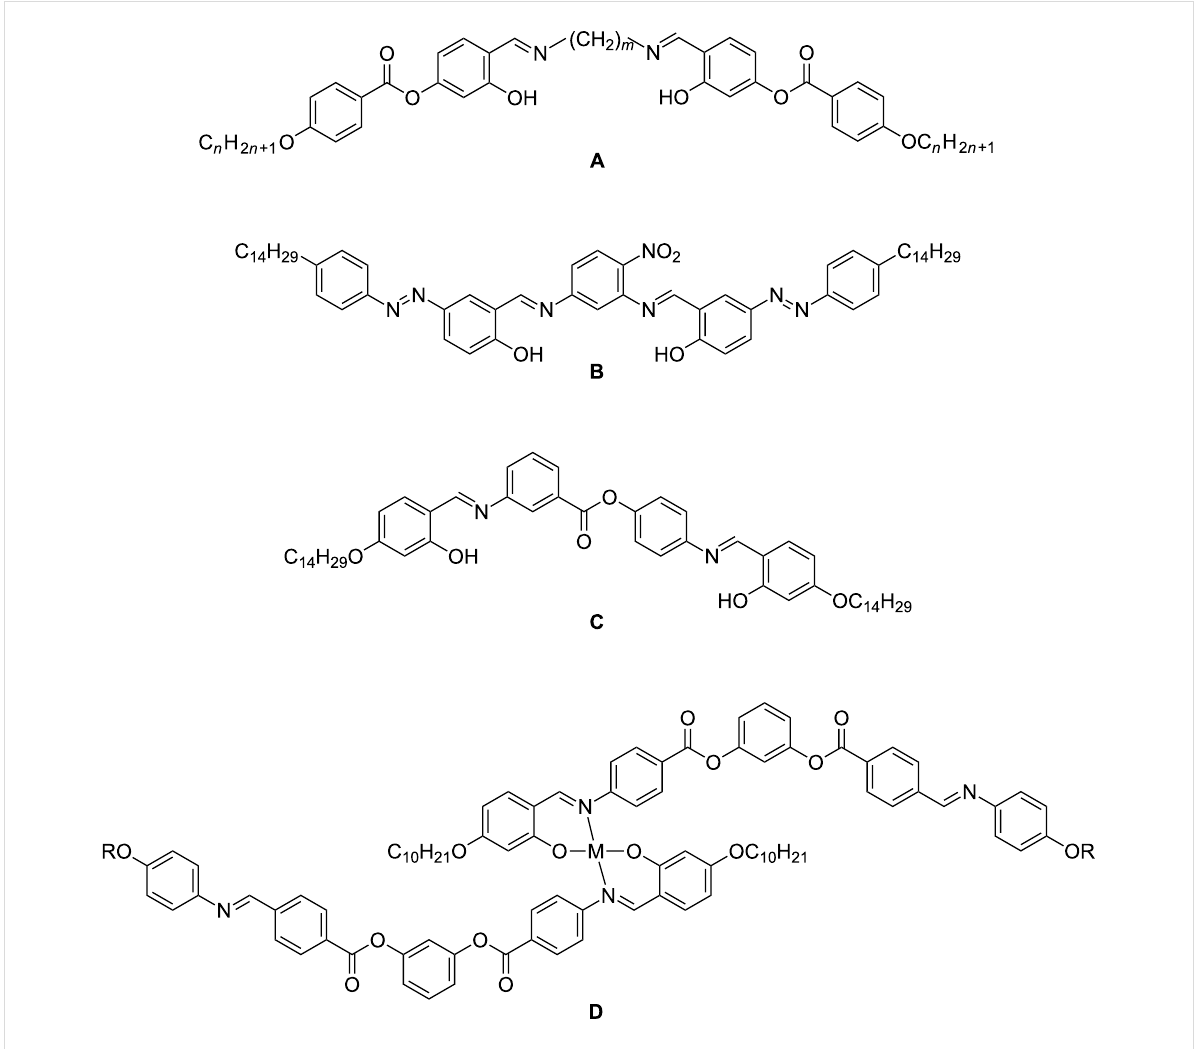
Scheme 1: Examples for bent mesogens containing salicylideneimine